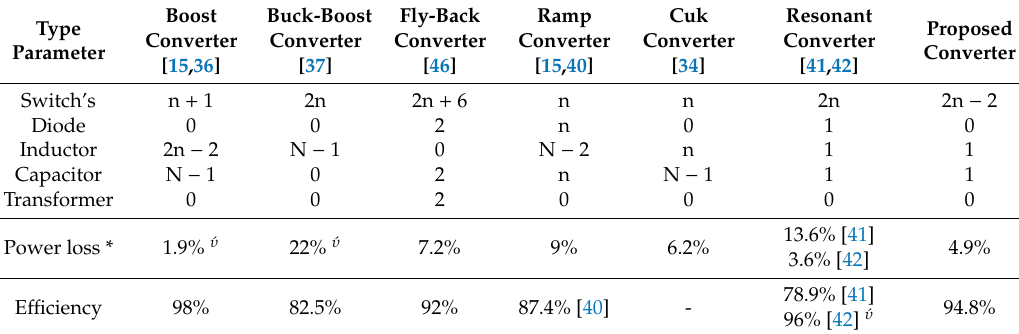
Table 2. Comparison along proposed voltage balancing